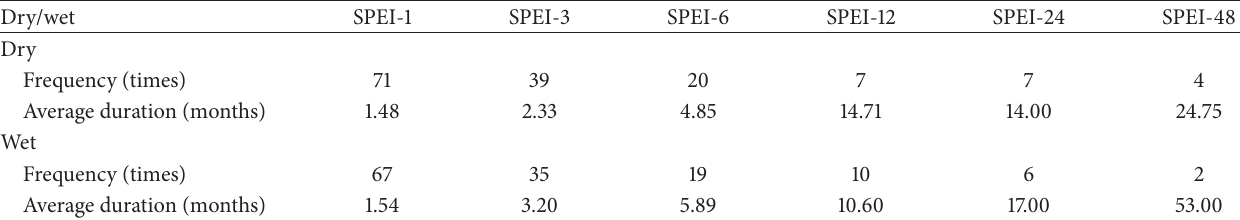
Table 2: Statistical results of frequency and average duration of dry and wet episodes according to different timescales of SPEI.